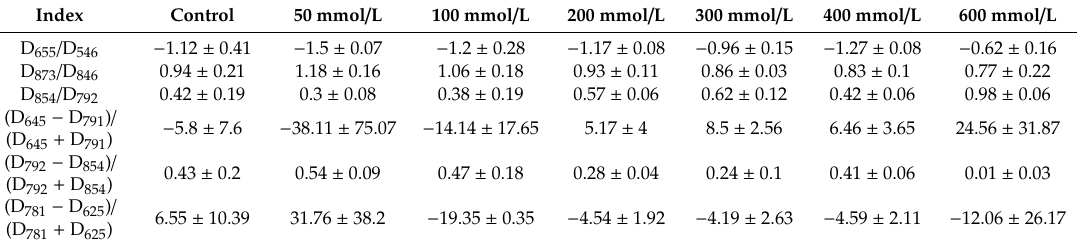
Table 5. Optimal VIs under di ff erent salt treatments with means ± standard errors (n =